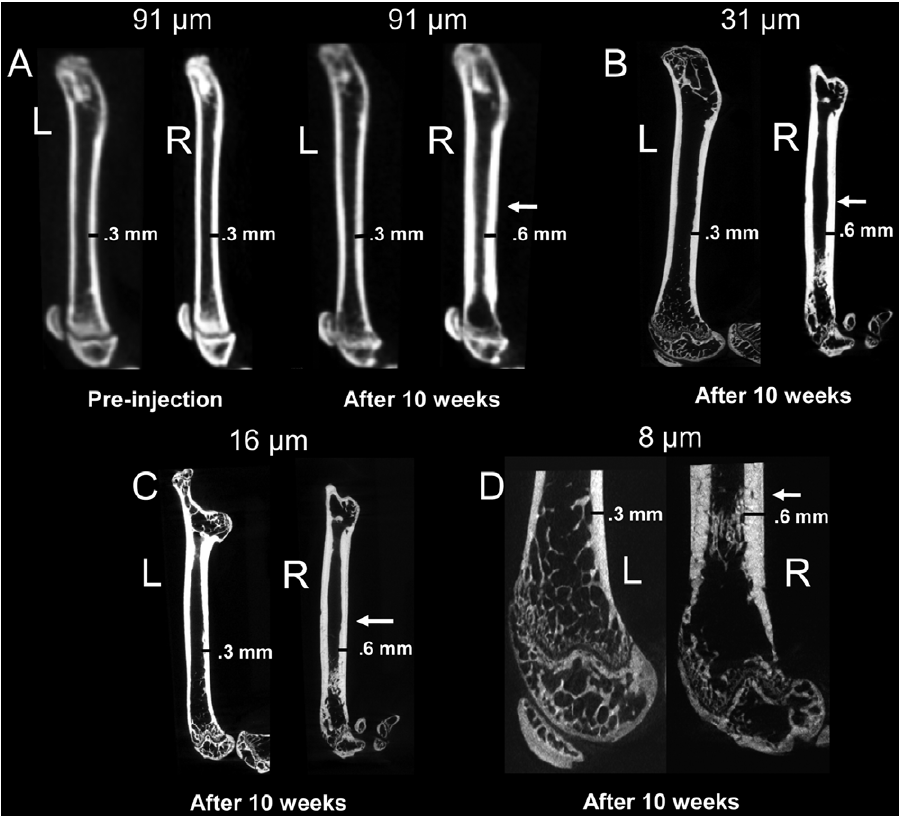
Figure 1. Representative in vivo and ex vivo m CT images demonstrate cortical thickening induced by prostate cancer involving bone. Sagittal in vivo longitudinal m CT scans obtained at 91 m m voxel size before and 10 weeks after (A) intrafemoral injection of vehicle control (left images) or MDA-PCa-2b human prostate cancer cells (right images) show cortical thickening (arrow) in the femora containing tumors. Ex vivo specimen m CT scans of excised femora at voxel sizes of 31- m m (B), 16- m m (C), and 8- m m (D) also show cortical thickening of the right femur with tumor. At the 8- m m voxel size, only the distal aspect of the femur was covered by the scans.